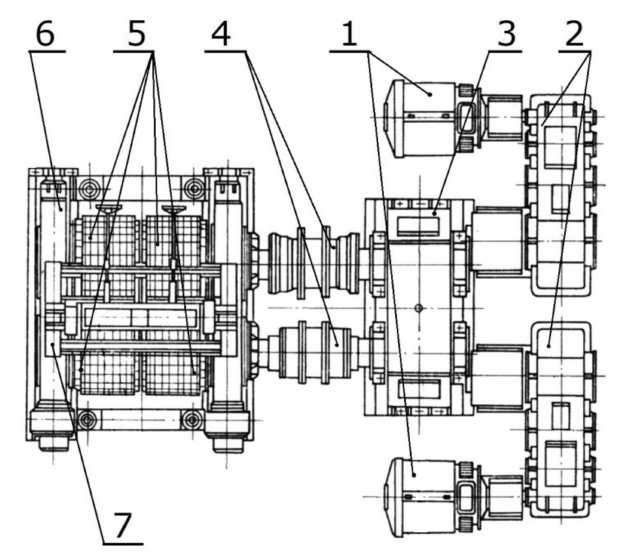
Figure 2. Scheme of roller press where the molding ring used for tests worked. ( 1 ) Electric drive; ( 2 ) Gearbox; ( 3 ) Synchronizing gearbox; ( 4 ) Clutch; ( 5 ) Molding rollers; ( 6 ) Frame with hydraulic system; ( 7 ) Feeder [43].